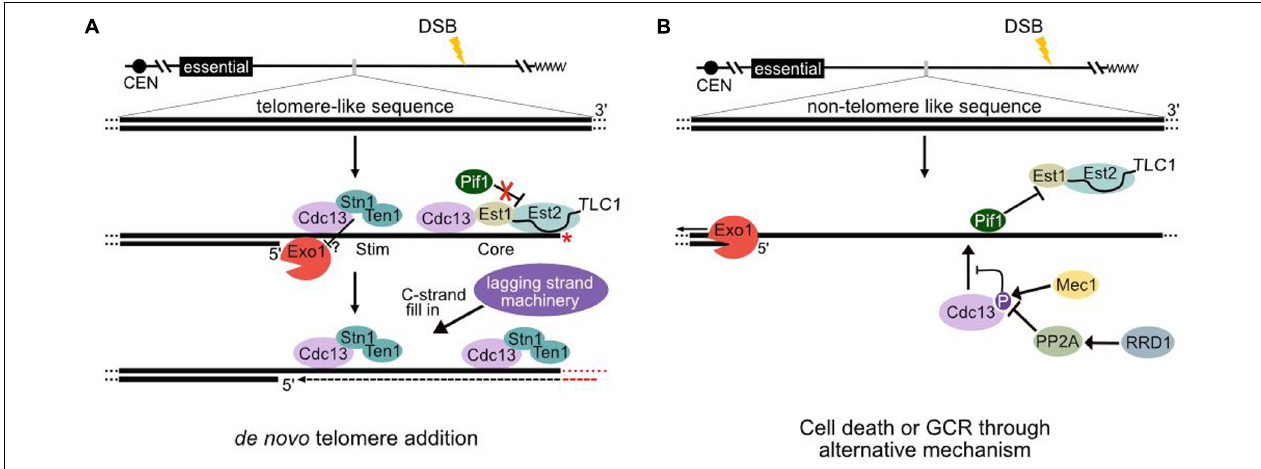
FIGURE 1 | Models of telomerase regulation at a resecting break in the presence and absence of telomere-like sequences. (A) Regulation of telomerase at endogenous hotspots of de novo telomere addition [Sites of Repair-associated Telomere Addition (SiRTAs)]. Following induction of a double-strand break (DSB), the MRX complex (Mre11–Xrs2–Rad50) along with Sae2 initiates 5’ end resection. Multiple nucleases act at DSBs, but extensive resection requires the exonuclease Exo1 and helicase Sgs1 (Gravel et al., 2008; Mimitou and Symington, 2008; Zhu et al., 2008). The resulting generation of single-stranded DNA (ssDNA) triggers a checkpoint kinase cascade and cell cycle arrest (Villa et al., 2016). Following resection through the TG-rich sequences, Cdc13 binds to a “Core” sequence and recruits telomerase through interactions with Est1. Cdc13, in complex with Stn1 and Ten1 [likely as a hexamer (Ge et al., 2020)], also binds to a proximal “Stim” sequence to prevent further 5 (cid:48) resection. The limited generation of ssDNA inhibits Pif1 loading and removal of telomerase (see text). While both the Stim and Core sequences are necessary to stimulate de novo telomere addition, it is unclear whether Cdc13 complexes bound to each are functionally distinct (as depicted here). Telomerase must access a 3 (cid:48) terminus, which is generated through an unknown mechanism to prime telomere synthesis (depicted by a red *). Following de novo telomere addition by telomerase, the CST complex recruits the lagging strand machinery for C-strand fill-in (see text). If the site of telomere addition is oriented correctly relative to the centromere, the resulting product is a stable truncated chromosome. (B) Regulation of telomerase at sequences lacking extensive TG-rich sequences. In the absence of DSB repair, 5’ resection proceeds unimpeded. Phosphorylation of Cdc13 at serine 306 by Mec1 inhibits Cdc13 accumulation at TG 1 - 3 sequences less than 11 bases (Zhang and Durocher, 2010). Pph3 phosphatase (in a manner requiring the activator Rrd1) counteracts Cdc13 phosphorylation (Zhang and Durocher, 2010), but Pif1 binds and inhibits telomerase action to strongly repress de novo telomere addition (Schulz and Zakian, 1994; Boulé et al., 2005; Li et al.,